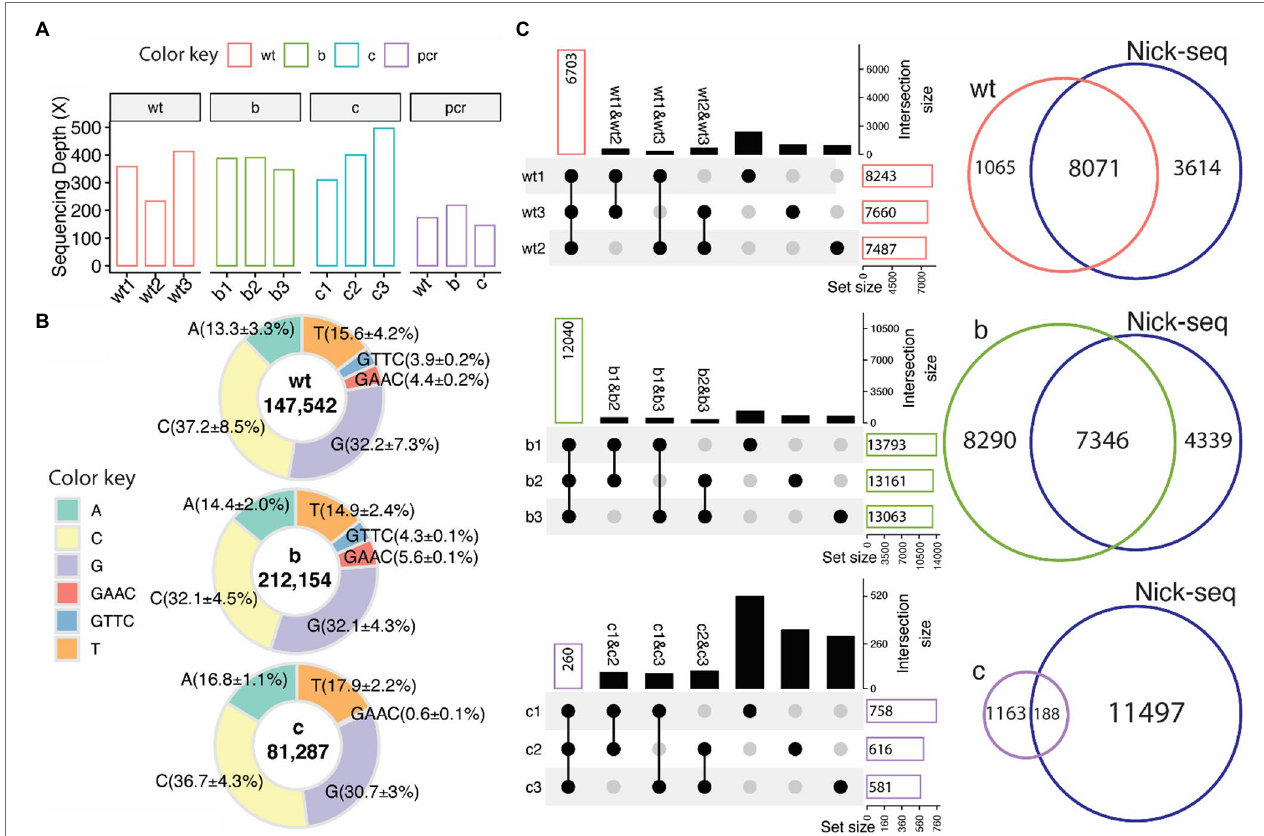
FIGURE 3 | PT modifications in Salmonella enterica from native DNA sequences. (A) Sequencing depth for wild type (wt), ∆ dndB (B) , ∆ dndC (C) , and modification-free reference PCR DNA from each strain (PCR). (B) Percentage distribution of modification sites of each base (A,T,C,G) and the two PT motifs (GAAC/ GTTC, backbone modifications classified by adjacent base) compared to the modification-free reference PCR DNA. ELIGOS determination of DNA modification sites (number inside the pie graph) including PT modification sites (GAAC/GTTC) within wild type, ∆ dndB , and ∆ dndC strains of S. enterica . (C) Upset plots (left panel), which compose of overlap matrix in dot plot with the overlap size in bar plots, show overlap of PT modification sites identified between replicates. The black dots represent the overlap of PT sites among samples connected with black lines. The bar plots reflect the overlap of detected PT modification sites in the selected replicates and the absence of a PT modification in the de-selected replicate. The gray dots represent no overlap found. The Venn diagram (right panels) shows overlap of PT modification sites identified by the ONT platform and Nick-seq data of S. enterica wild-type